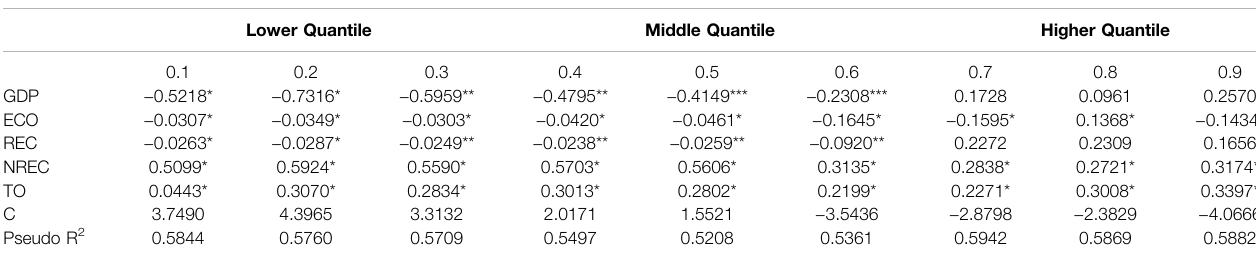
TABLE 8 | Panel quantile Regression